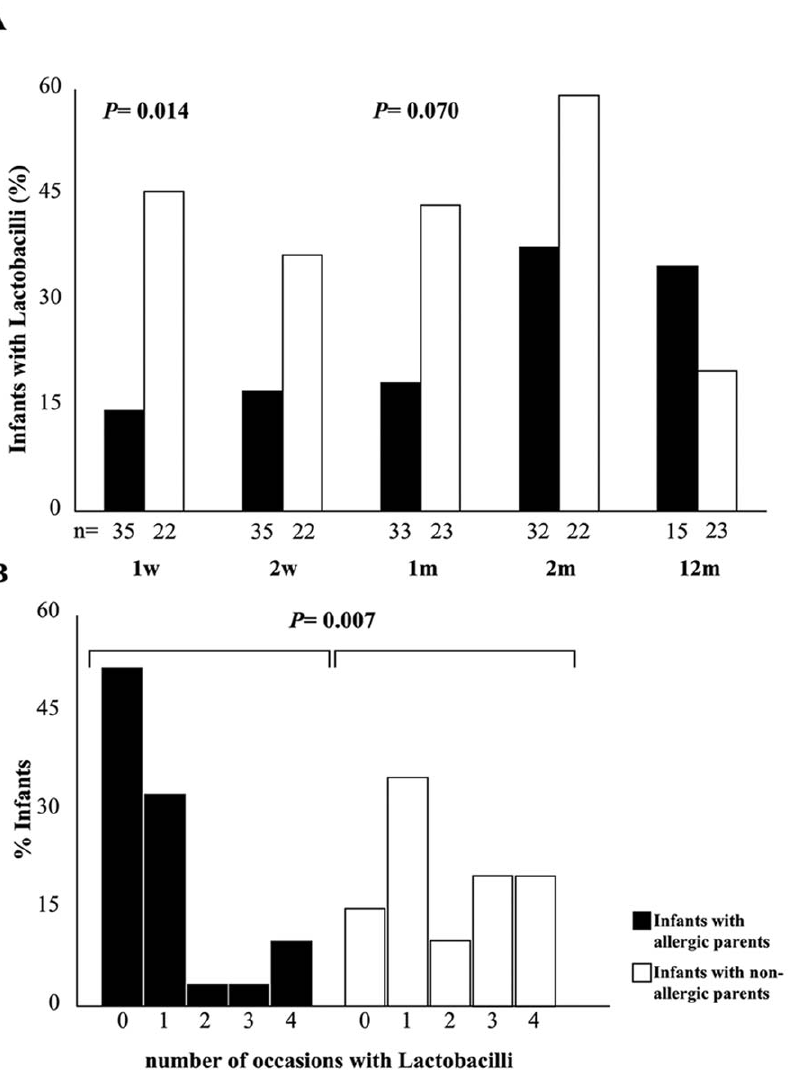
Figure 1. Intestinal colonization with Lactobacilli in infants with allergic and non-allergic parents respectively. The y-axis shows percentage infants colonized at the different time points ( A ) and percentage infants colonized 0, 1, 2, 3 or 4 occasions the first two months of life in ( B ).